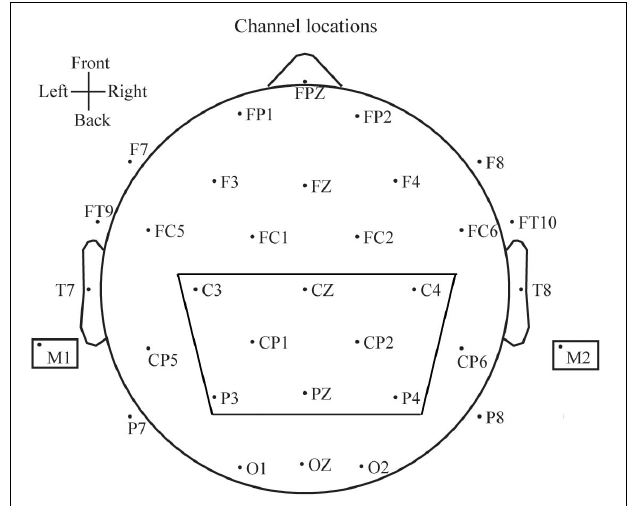
FIGURE 3 | Electrode distribution